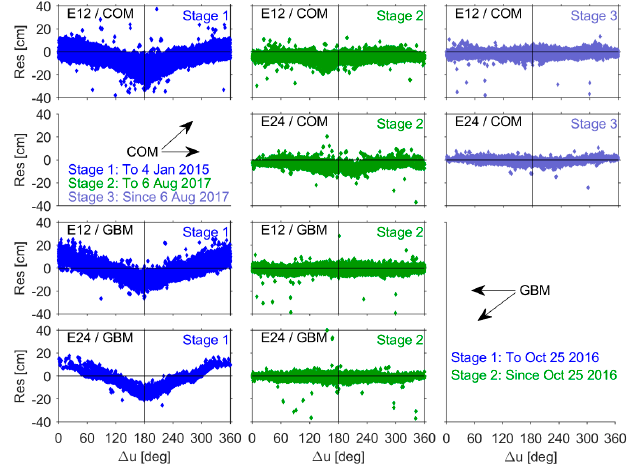
Figure 11. SLR residuals as a function of relative Sun–satellite latitude Δ u.